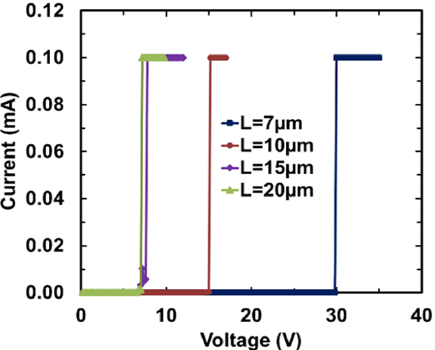
Figure 9. Samples of gNEMS devices with L = 7 µm, 10 µm, 15 µm, and 20 µm show the turn-on behavior at di ff erent DC sweeping voltages.